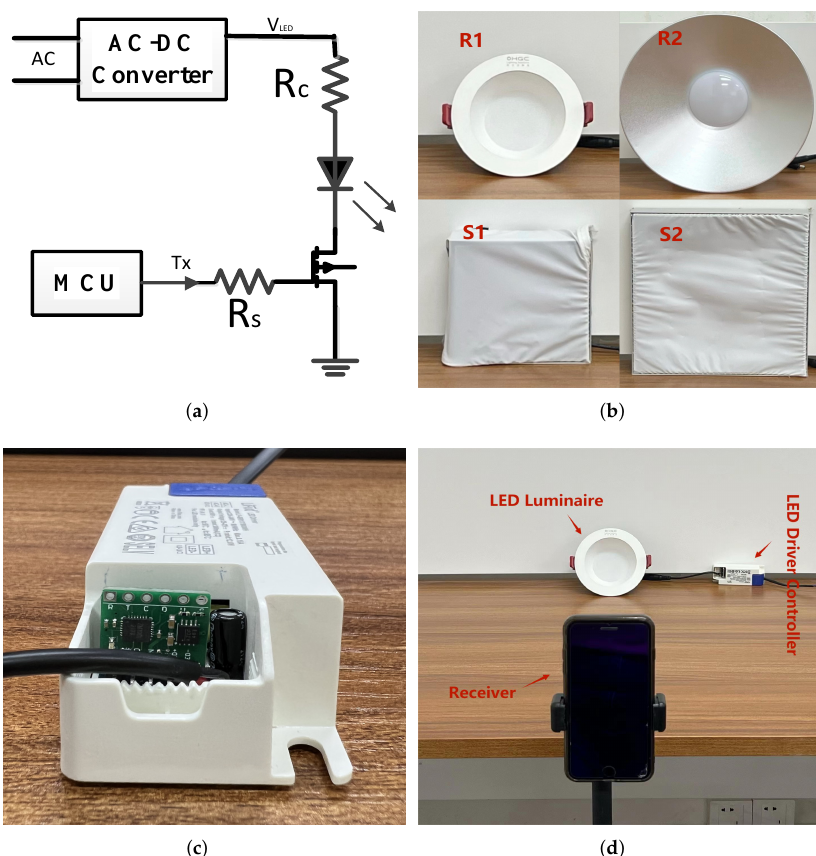
Figure 6. The experiment setup of the proposed OCC system. ( a ) Modulation circuit diagram for modulation circuitry. ( b ) LED transmitters in different shapes and sizes. ( c ) LED driver controller. ( d ) Experimental scenario for the proposed OCC